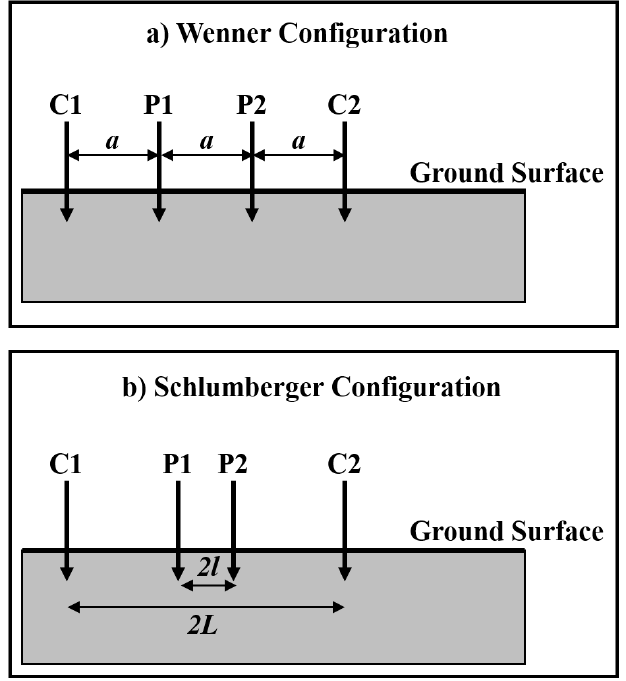
Figure 2. The two spreads used in the field recording, ( a ) Wenner and ( b ) Schlumberger spreads. C1 and C2 are the two current electrodes while P1 and P2 are the potential electrodes. The offset between any two successive electrodes in the Wenner spread is ‘a’; the offsets between the two current and the two potential electrodes in the Schlumberger spreads are ‘2L’ and ‘2l’, respectively.